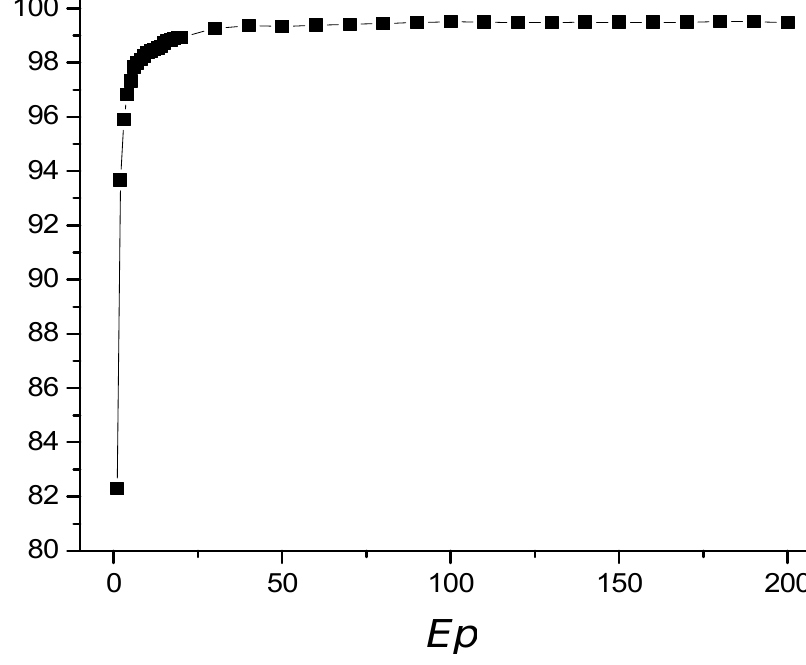
Figure 5. Dependence of A 46 ( FR [21,37,40,42,49]) on the number of epochs Ep . Table 5. Classification metrics depending on the number of training epochs Ep .